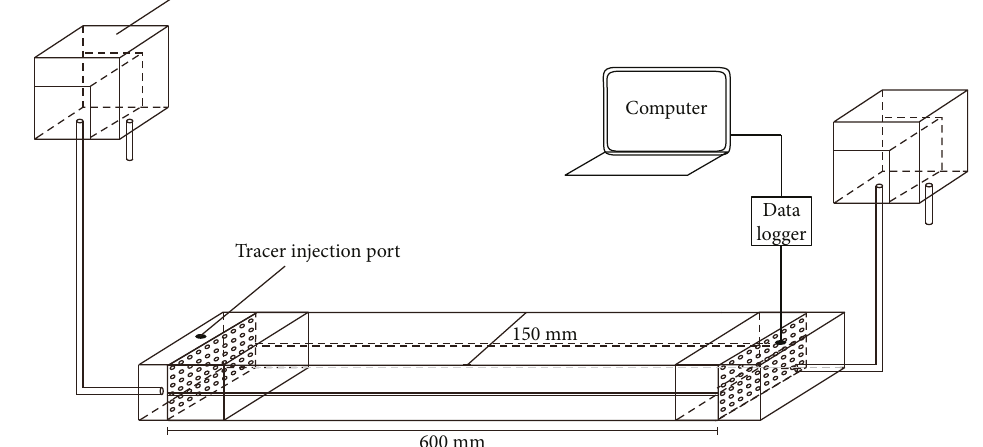
Figure 1: Schematic diagram of fracture in marble parallel plates.